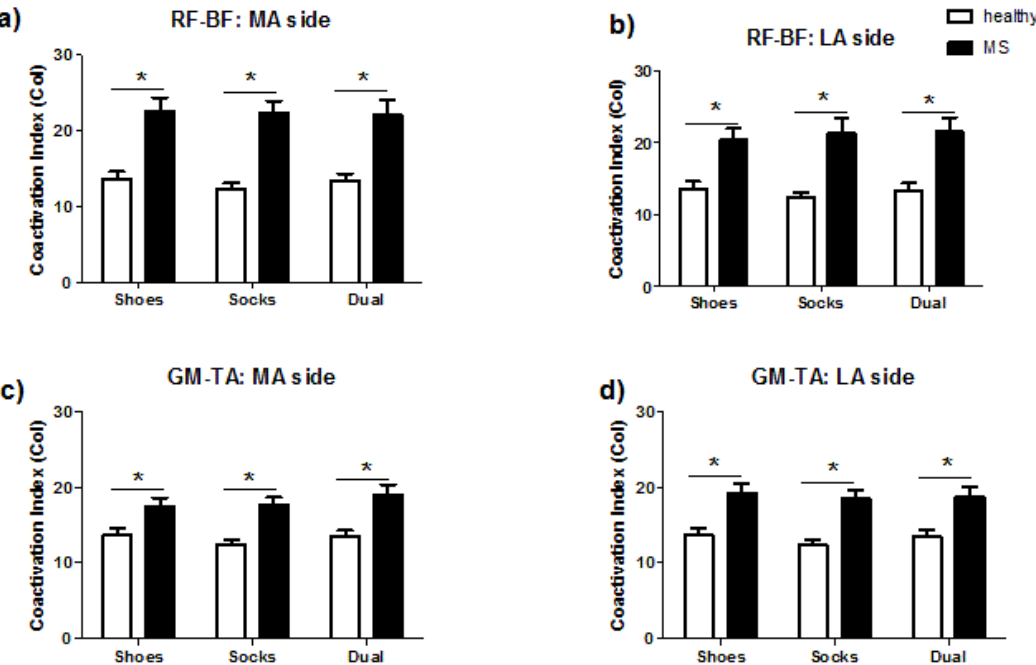
Figure 2. The inter-group di ff erence of the coactivation index. Two-way ANOVA showed significant group di ff erence of coactivation in both the MA and LA side in RF-BF ( a , b ) and GM-TA ( c , d ), while no significant di ff erence was found among conditions. *: p < 0.01 in posthoc analyses.